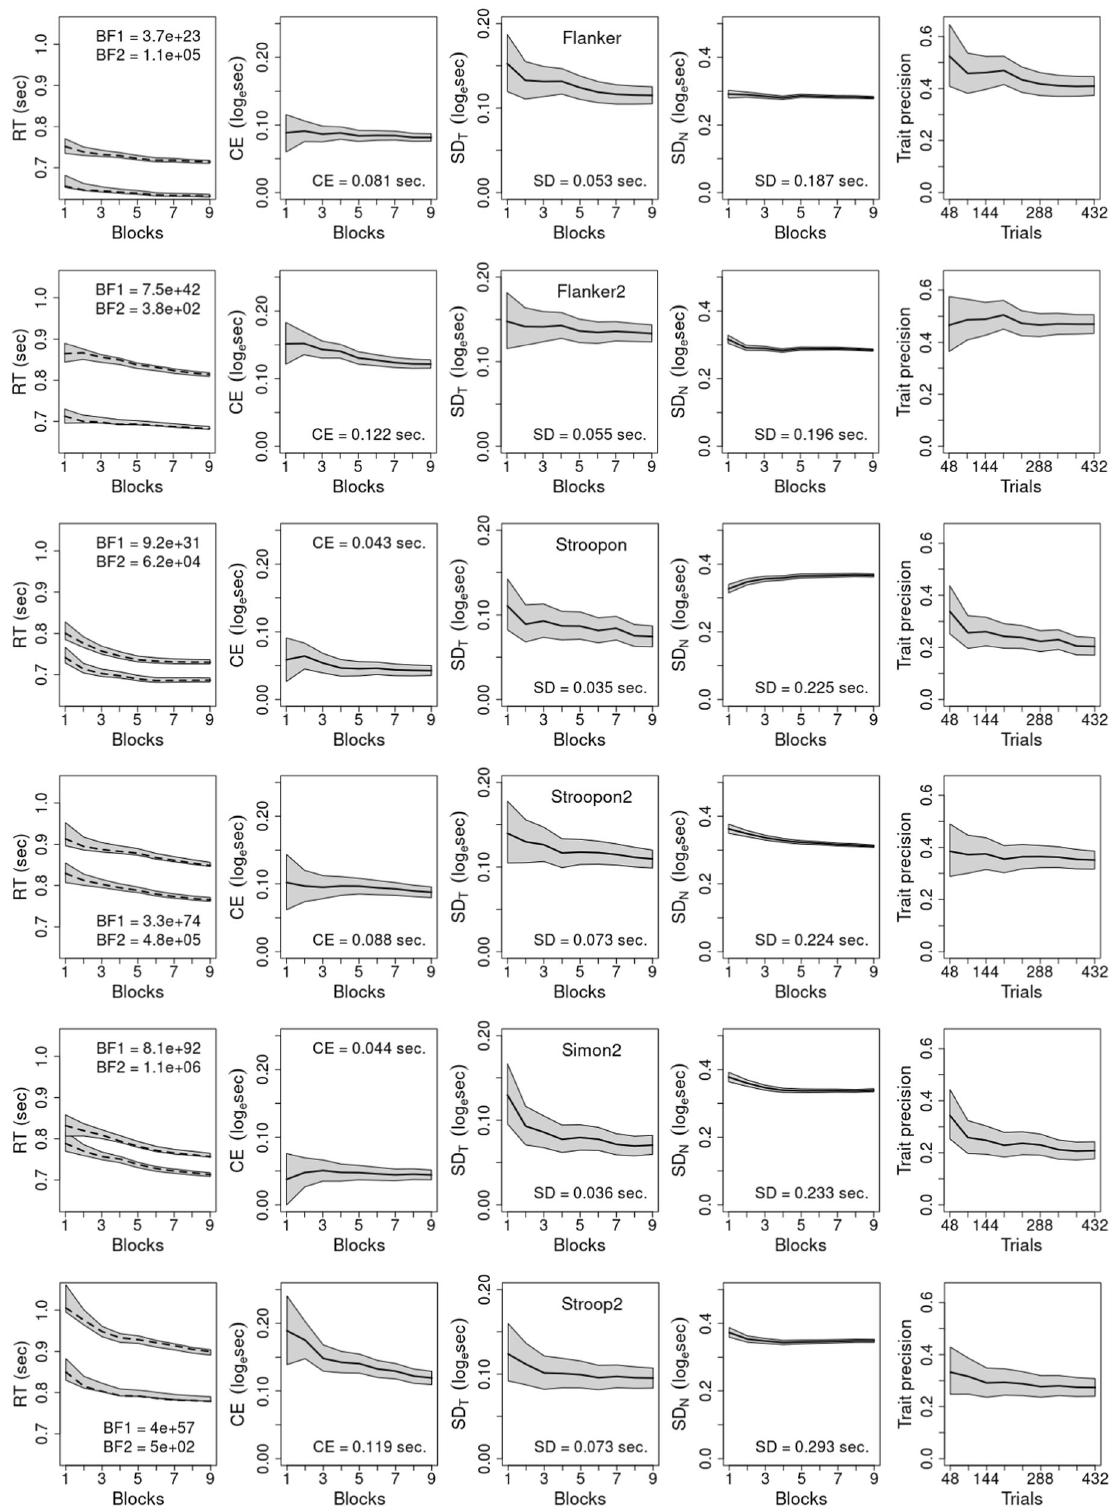
Fig. 6 | Results for gami fi ed experiment. The model assumes additive practice (blocks) and con fl ict fi xed effects, and random subject intercepts and con fl ict slopes.Blocksrefertocumulativesetsof48trialsandeachrowrepresentsonetask. In the fi rst column, dashed lines show meanresponse time (RT)for congruent and incongruent conditions calculated directly from data and Bayes Factors (BF) comparetheassumedmodelinthenumeratortomodelswith(1)nopracticeeffect